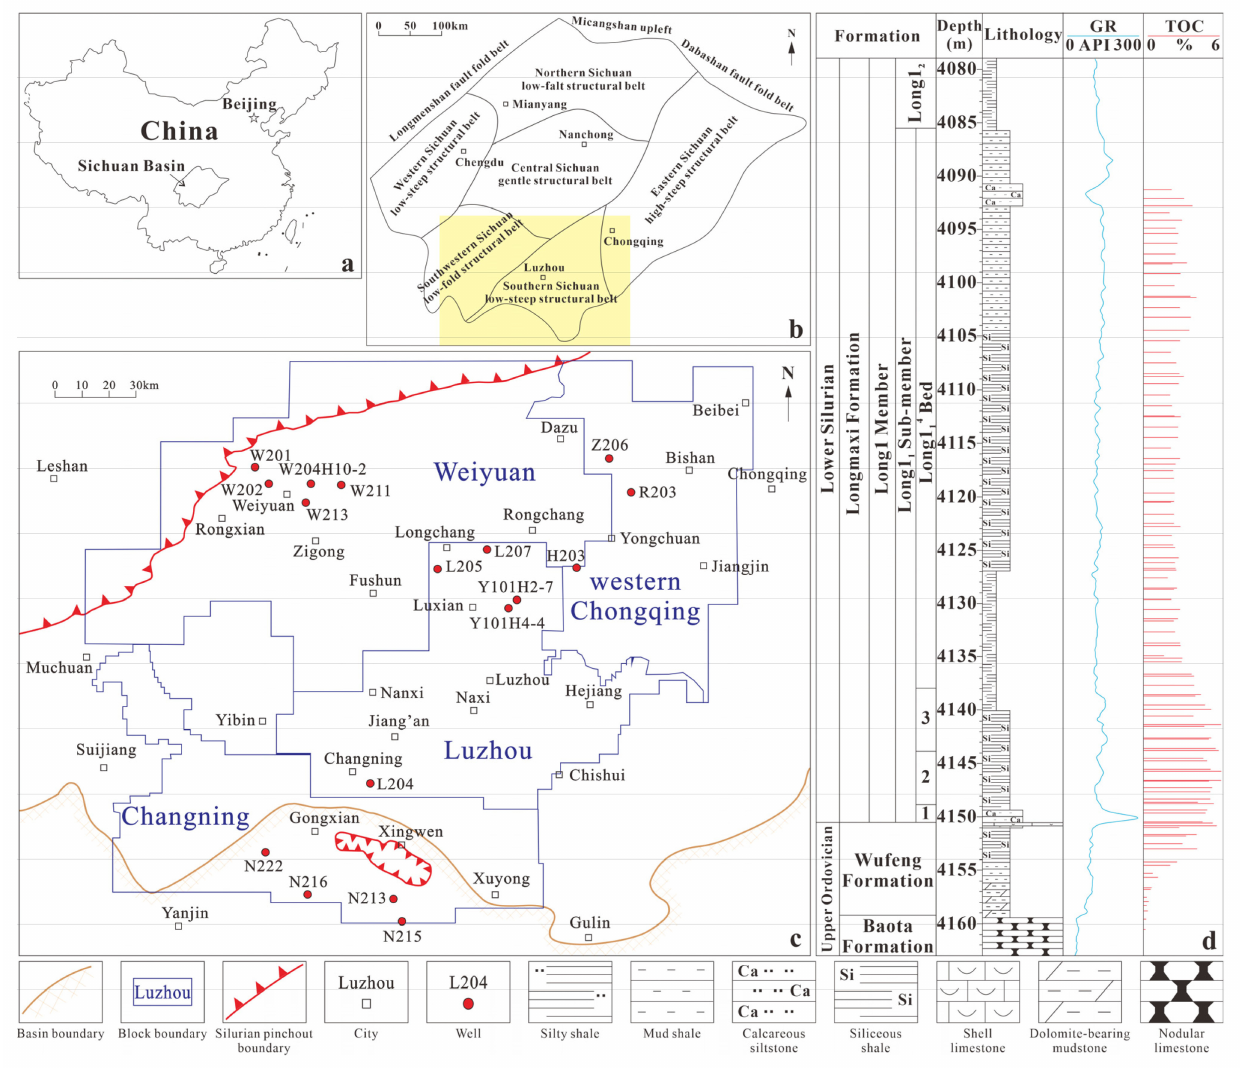
Figure 1. Location of the study area and wells ( a – c ), and the Wufeng Formation–Long1 1 sub-member stratigraphic column of Y101H4-4 well ( d